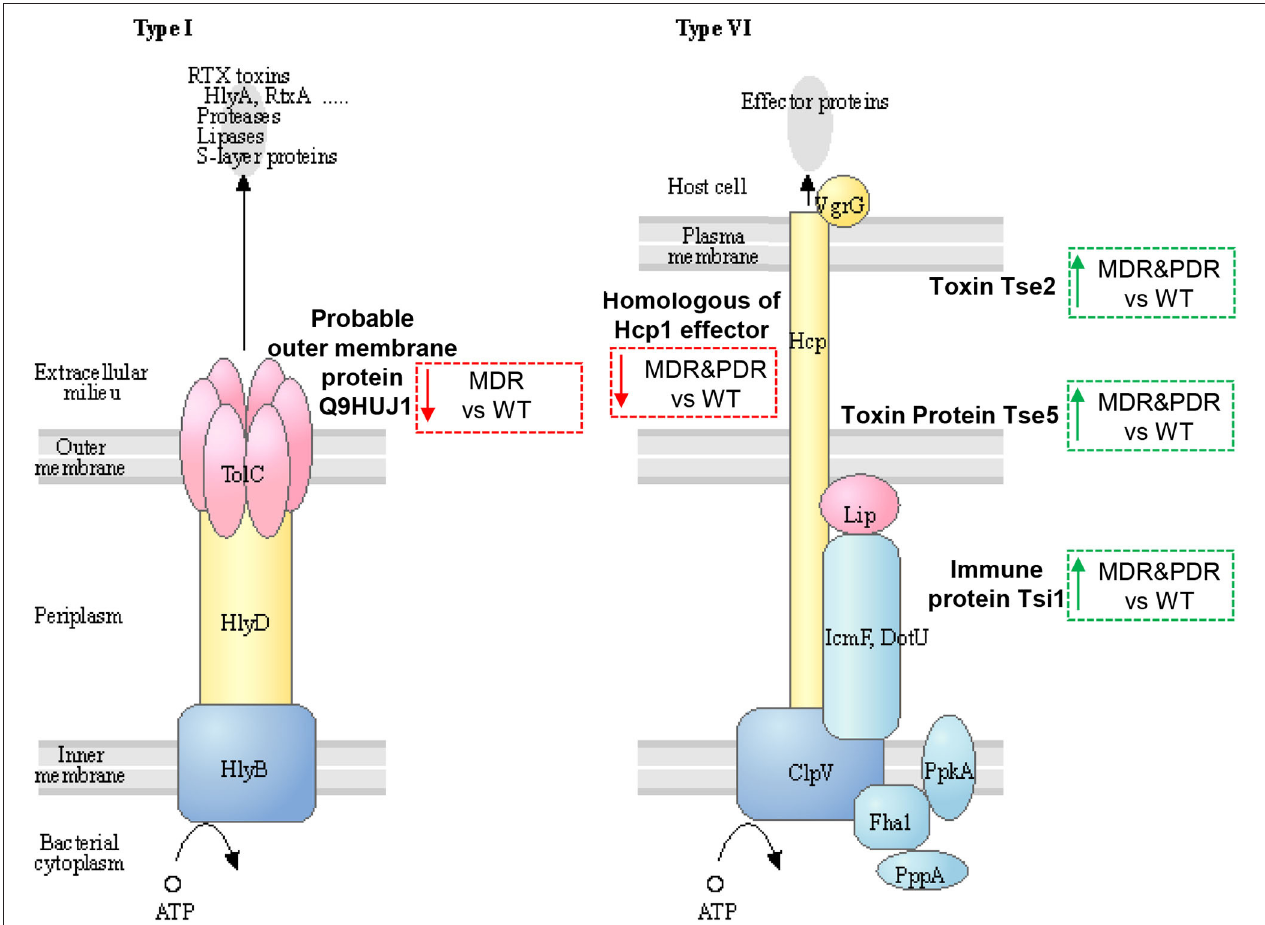
FIGURE 5 | Sketch of two secretion systems (Type I and VI), transporting microbial substrates across membranes of Gram-negative bacteria in one step. Image modified from pae03070 KEGG (release 99.0, July 1, 2021) pathway depicting participating factors, proteins, complexes, and their subcellular distribution. MDR and PDR P. aeruginosa clinical strain identified proteins are evidenced by dashed box along with their shift of expression compared to WT strains (red dashed box and downward arrow = under-expression; green box and upward arrow = over-expression). Probable outer membrane protein (UniProtKB code Q9HUJ1, KEGG identifier PA4974) is localized in the outer membrane and involved in bacterial secretion system Type I. The identified Uncharacterized protein (Q9I1B2) is a homologous of Hcp1 family type VI secretion system effector and is mapped by KEGG software (KEGG identifier PA2367) as type VI secretion system secreted protein Hcp ortholog. Toxin Tse2 (Q9I0E0), Toxin protein Tse5 (Q9I0F4) and Immune protein Tsi1 (Q9I2Q0) are other members of the type VI secretion